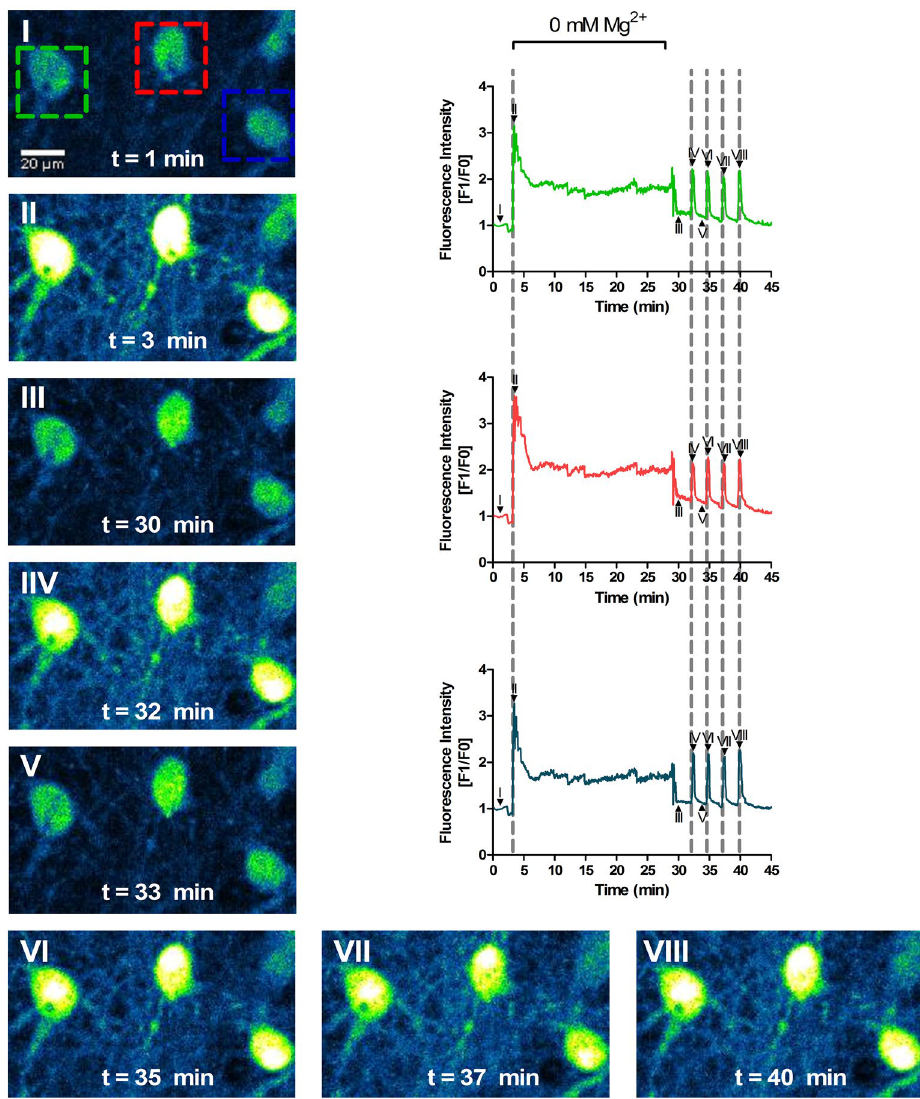
Figure 2. [Mg 2+ ] 0 increases the [Ca 2+ ] i and induces the development of spontaneous calcium oscillations. Cultured hippocampal neurons (15 DIV) were analysed by Single-Cell Calcium Imaging using the fluorescent Ca 2+ indicator Fluo-4, by Spinning Disk microscopy. The cells were initially incubated under control conditions (with 2 mM Mg 2+ ) for 3 min to determine the baseline levels of calcium. After 3 min, the medium was replaced with [Mg 2+ ] 0 medium for the indicated stimulation period. At 30 min, the medium was replaced by control salt solution for an additional period of 15 min. Fluo-4 fluorescence was recorded for the duration of the incubation. For each time point the results are represented as the normalized intensity of Fluo-4 fluorescence (Fluorescence for a given time point divided by the baseline fluorescence). The time courses represent the [Ca 2+ ] i changes in the neurons indicated by a coloured square. The images (I–VIII) represent key time points of the Fluo-4 fluorescence recording and their position in the traces is also shown. The dashed lines portray the synchronous neuronal calcium fluctuation pattern. A video of a representative experiment is shown in Supplementary Video